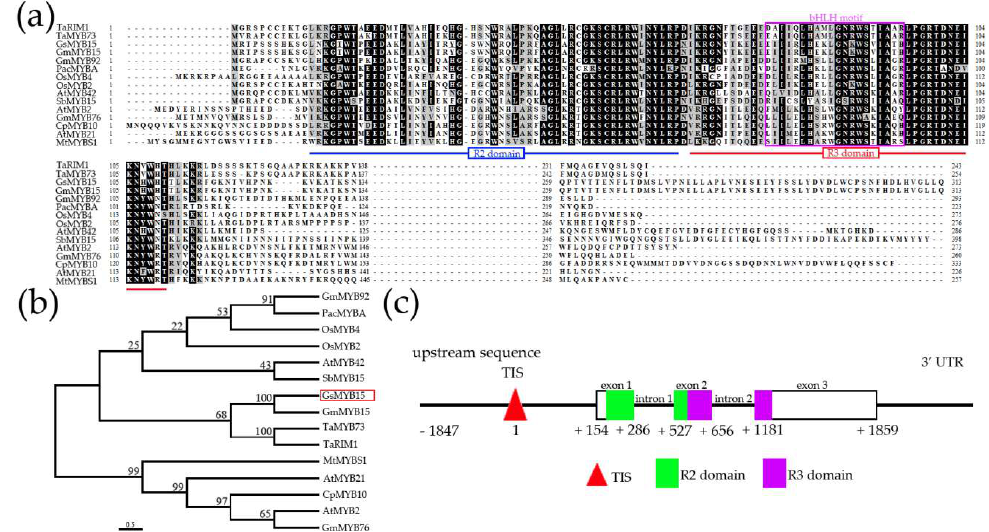
Figure 1. Phylogenetic relationship between the protein sequences of GsMYB15 and stress-related R2R3 MYBs from other species and genomic sequence analysis of GsMYB15 . ( a ) Protein sequence alignment of GsMYB15 with known stress-related R2R3 MYBs from other species. The R2R3-binding domain is underlined. Green boxes indicate specific residues from the motif implicated in the bHLH cofactor interaction in Arabidopsis [38]. The accession numbers of these proteins in the GenBank database are as follows: PacMYBA (KF974774), AtMYB42 (AEE83118), AtMYB2 (BAA03534), OsMYB4 (BAA23340), OsMYB2 (BAA23338), CpMYB10 (AAM43912), MtMYBS1 (AES60982), SbMYB15 (AKP07635), TaMYB73 (AEW23186), GmMYB15 (Glyma.12g199200), TaRIM1 (AMP18876), AtMYB21 (EFH51661), GmMYB76 (Glyma.02g009800), GmMYB92 (Glyma.16g023000) and GsMYB15 (MH796674). ( b ) Phylogenetic tree of GsMYB15 and other stress-related R2R3 MYB proteins from diverse species. The scale bar indicates 0.5 substitutions per site. ( c ) Structure of the GsMYB15 gene sequence. The promoter, introns and 3’UTR are indicated by lines. The transcription initiation site (TIS) and the R2R3 MYB domains are shown as triangles and solid boxes, respectively. Numbers refer to the position relative to the TIS of GsMYB15 . Table 1. Cis -acting elements potentially associated with the stress response of GsMYB15 .